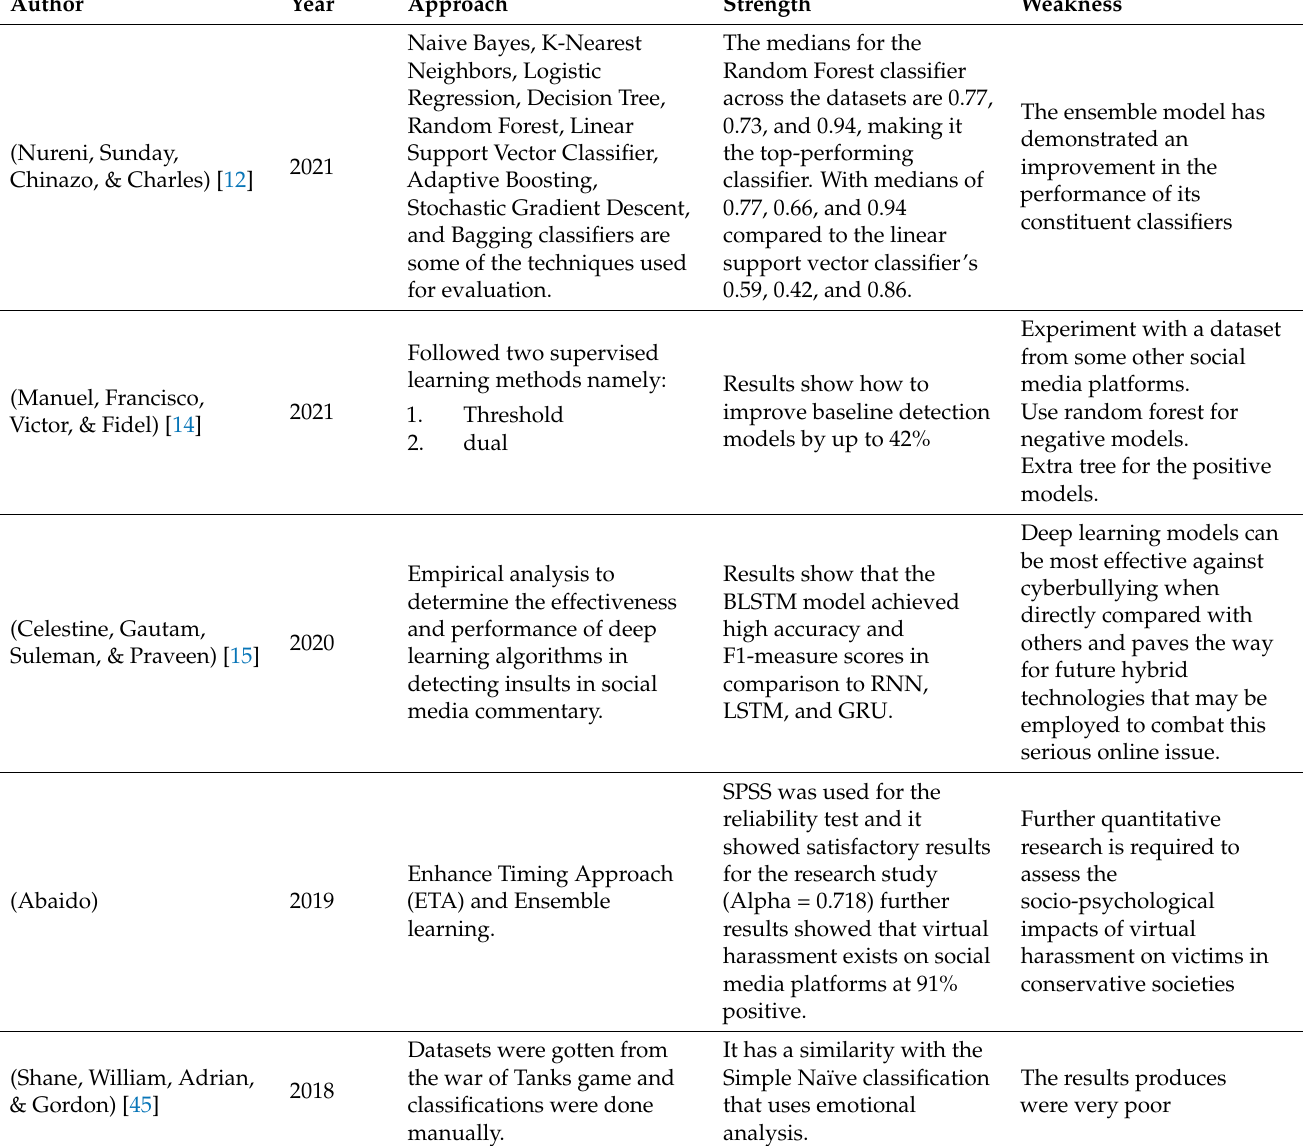
Table 1. Summary of related